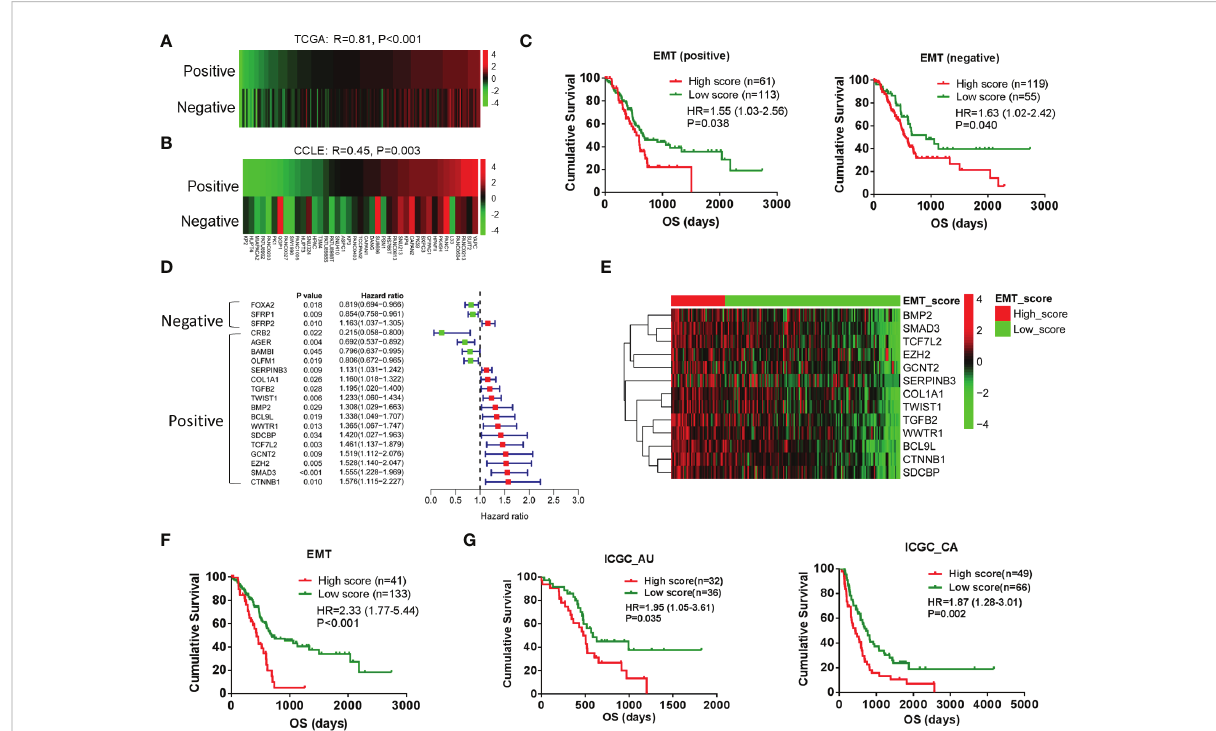
FIGURE 1 Rede fi ning of EMT signature by prognosis analysis in pancreatic cancer. (A, B) Pearson correlation analysis between EMT-related gene sets positively (n = 34) regulating EMT and EMT-related gene sets negatively (n = 23) regulating EMT by using GSVA scores in TCGA (PAAD patients) and CCLE databases (PAAD cell lines). (C) Kaplan – Meier analysis of overall survival using GSVA scores of the above two gene sets. (D) Forest plot shows the results of univariate Cox analysis of genes in the above two gene sets. (E) Heatmap shows the gene expression of 13 EMT-related genes in low-score and high-score groups. (F) Kaplan – Meier analysis of overall survival of low-score and high-score groups. (G) Kaplan – Meier analysis of overall survival based on the GSVA scores of gene set was performed in other two cohorts in ICGC database. EMT, epithelial-to- mesenchymal transition; GSVA, gene set variation analysis; TCGA, The Cancer Genome Atlas; CCLE, Cancer Cell Line Encyclopedia; ICGC, International Cancer Genome